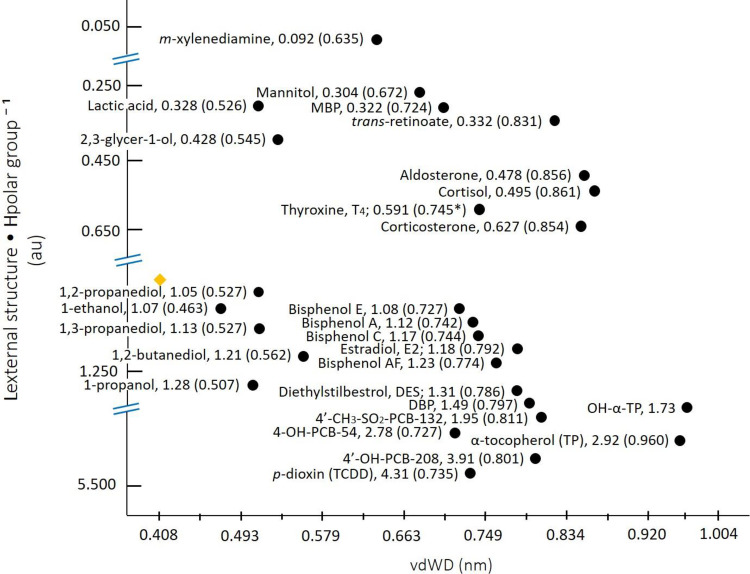
Molecular structural lipophilicity per polar group hydrophilicity intervals for acyclic and cyclic small molecule hormone receptor axis endogenous ligands and inverse agonists.The Lexternal · Hpolar group-1 interval for non-selective carrier-mediated diffusion through polarity-specific transport channels is ≤ 1.07, which includes alkanols (1-propanol, 1.28; 1,2-butanediol, 1.21; 1,3-propanediol, 1.13; 1-ethanol, 1.07; vdWD, 0.463–0.562 nm) in addition to bisphenols [BPA—BPE, 1.08–1.12, intracellular (ERRγ/ERRα), vdWD 0.727–0.742 nm; BPC, intracellular–BPAF, extracellular 1.17–1.23, vdWD 0.744–0.774 nm (ERα/ERβ, GPER)], and diethylstilbestrol (DES; 1.31, vdWD 0.786 nm) as toxicants within the Lexternal · Hpolar group-1 interval 1.08–1.31, and PCB metabolites 4-OH-PCB-54, 2.78 (vdWD 0.727 nm), 4’-OH-PCB-208, 3.91 (0.801 nm) and 4’-CH3-SO2-PCB-132, 1.95 (0.811 nm), and p-dioxin (TCDD), 4.31 (0.735 nm) as toxicants within the Lexternal · Hpolar group-1 interval 1.95–4.31 (OH-PCB-3, L · H-1 = 2.13; not shown). The Lexternal · Hpolar group-1 interval for endogenous small molecule hormone ligands for the CM MR receptor is within the interval 0.478 (Aldosterone) and 0.495 (Cortisol), and for the CM GR receptor is around 0.627 (Corticosterone). The Lexternal · Hpolar group-1 for complete OH-Iodothyroxine (T4) zwitterion adjusted for intervening ether is 0.591, while the Lexternal · Hpolar group-1 for (4’-hydroxy-3’,5’-diiodophenoxy)-1-ethyl-3,5-diiodophenyl (non-zwitterion part-T4) is 3.24. The Lexternal · Hpolar group-1 interval for the broad selectivity CM hydroxylate channel polarity-specific substrates is between 0.328–0.428 (vdWD range 0.526–0.672 nm). Saxitoxin (STX) with internal structural lipophilicity has a Lexternal · Hpolar group-1 of 0.101 (not shown), as compared to m-xylenediamine with external structural lipophilicity and a Lexternal · Hpolar group-1 of 0.098. The Lext · H-1 interval ranges for substrate binding affinity to CYP450 monooxygenases, UDP-glucouronosyl-/sulfo-transferases, and ester hydrolases is 1.91–4.31 (p-dioxin, OH-p-2,3,7-TriCDD), 1.73–2.69 (OH-α-tocopherol, UGT1A_; OH-PCB-3, SULT1A_) and 0.322–1.49 (mono-butylphthalate, MBP; dibutylphthalate, DBP), respectively. The Lext · H-1 interval (min) for glucouronidation is 0.419 (glucouronate-2,3,7-TriCDD)– 0.459 (glucouronate-α-tocopherol). ◊ Methanol reference standard, 1 * Thyroxine, vdWD is adjusted for x, y plane-dimensional aspect (0.745 nm).